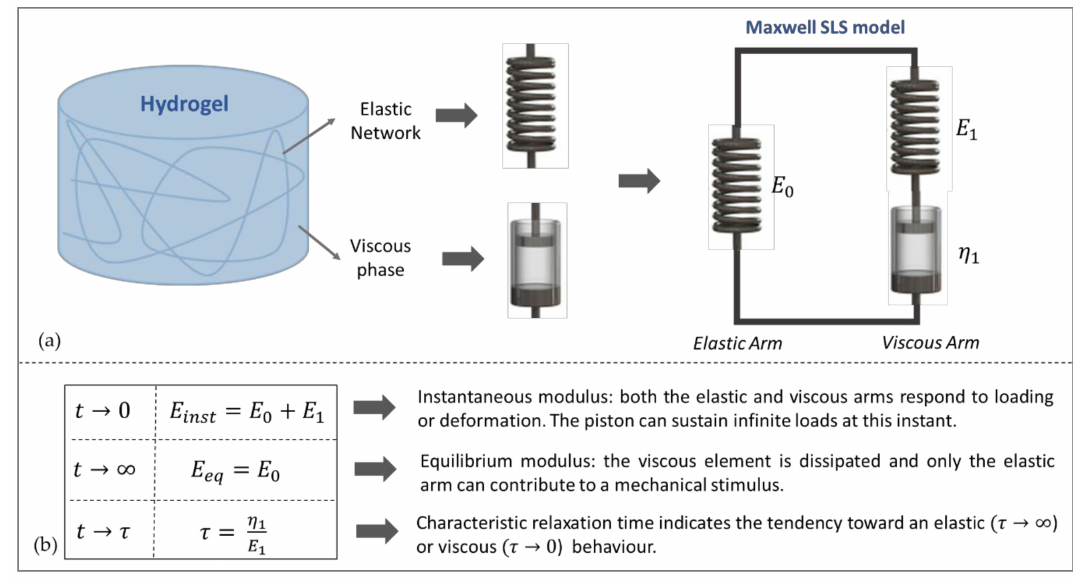
Figure 1. Representing hydrogel viscoelasticity with lumped parameter models: ( a ) The Maxwell-type Standard Linear Solid (SLS) model; ( b ) relationships between the lumped parameter elements and the instantaneous ( E inst ) and equilibrium ( E eq ) elastic moduli and the characteristic relaxation time ( τ